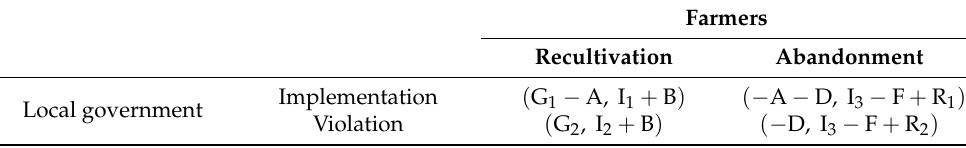
Table 5. Payment matrix of the game between farmers and local